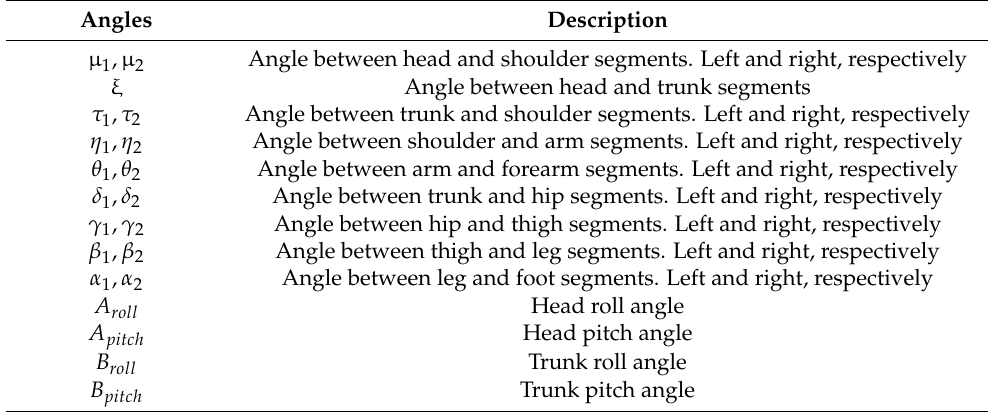
Table 1. Joint angles between two body segments are computed in the space, and absolute joint angles are calculated between a body segment and the horizontal plane passing through the two hips and the two shoulders. Angles Description µ µ 1 , 2 Angle between head and shoulder segments. Left and right, respectively ξ Angle between head and trunk segments τ 1 , τ 2 Angle between trunk and shoulder segments. Left and right, respectively η 1 , η 2 Angle between shoulder and arm segments. Left and right, respectively θ 1 , θ 2 Angle between arm and forearm segments. Left and right, respectively δ 1 , δ 2 Angle between trunk and hip segments. Left and right, respectively γ 1 , γ 2 Angle between hip and thigh segments. Left and right, respectively β 1 , β 2 Angle between thigh and leg segments. Left and right, respectively α 1 , α 2 Angle between leg and foot segments. Left and right, respectively A roll Head roll angle A pitch Head pitch angle B roll Trunk roll angle B pitch Trunk pitch